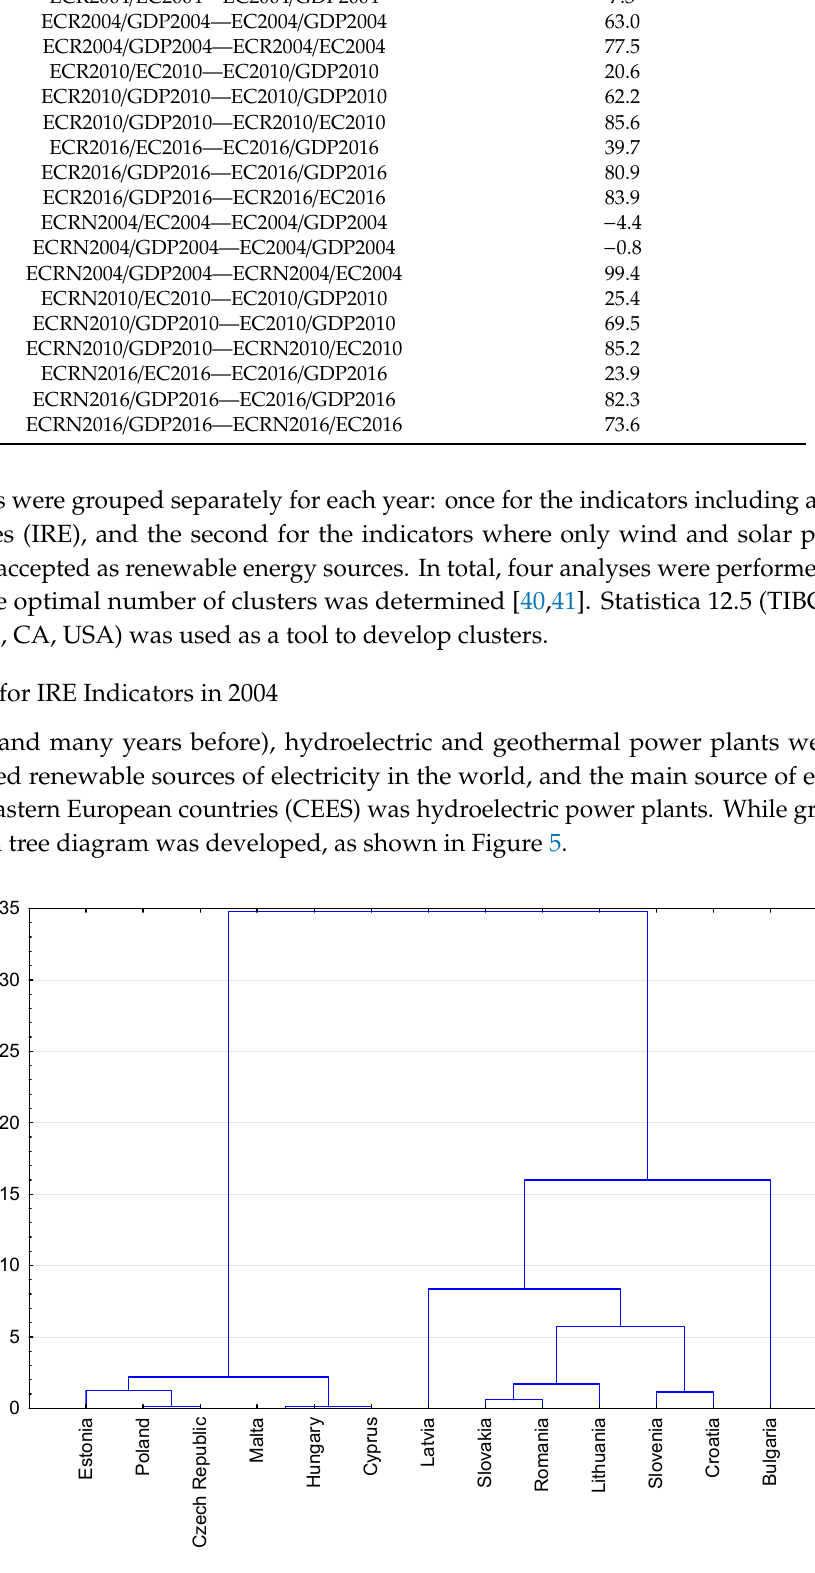
Figure 5. Tree Diagram for IRE in 2004.